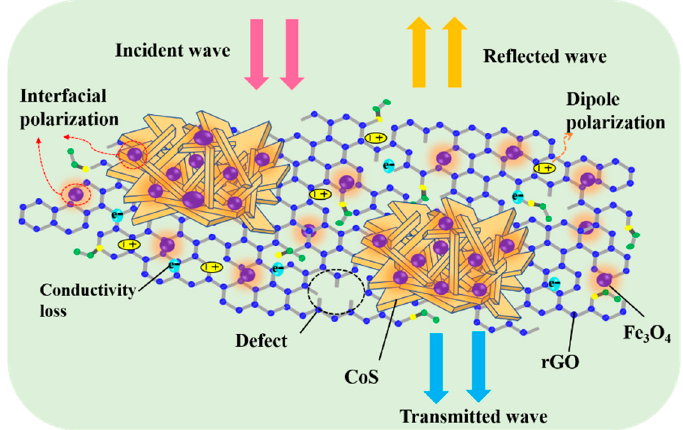
Figure 11. Mechanism illustration of the microwave absorption of the CoS@Fe 3 O 4 @rGO aerogel. Figure 10. ( a ) The attenuation constant and ( b ) impedance matching ratio of the samples.